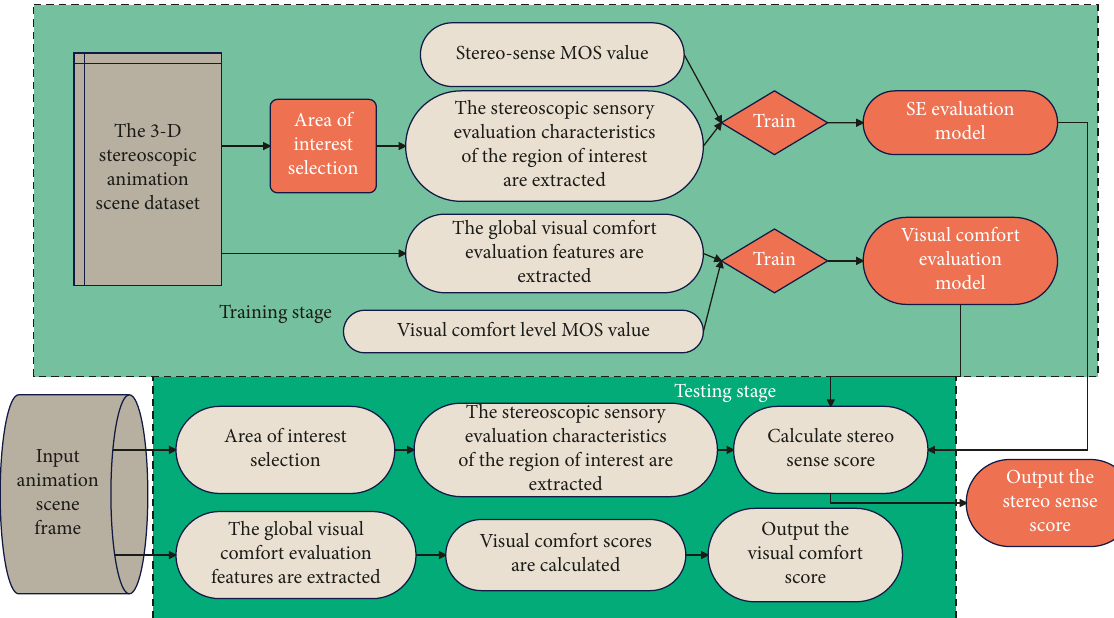
Figure 7: The overall process of evaluation for the preproduction of 3D stereo animation realized by the evaluation model in this paper.